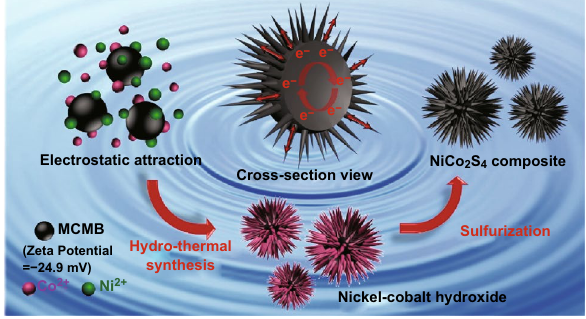
Fig. 1 Schematic illustration of the synthesis procedure of the urchin-like NCS@MCMB composites